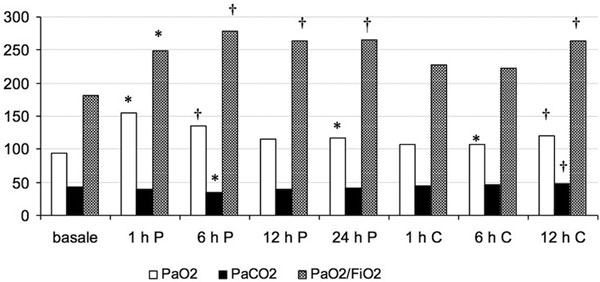
Mean PaO2, PaCO2, PaO2/FiO2 at baseline and during HFOV (P, percussionator; C, conventional). *P <0.05 versus baseline, †P <0.01 versus baseline.